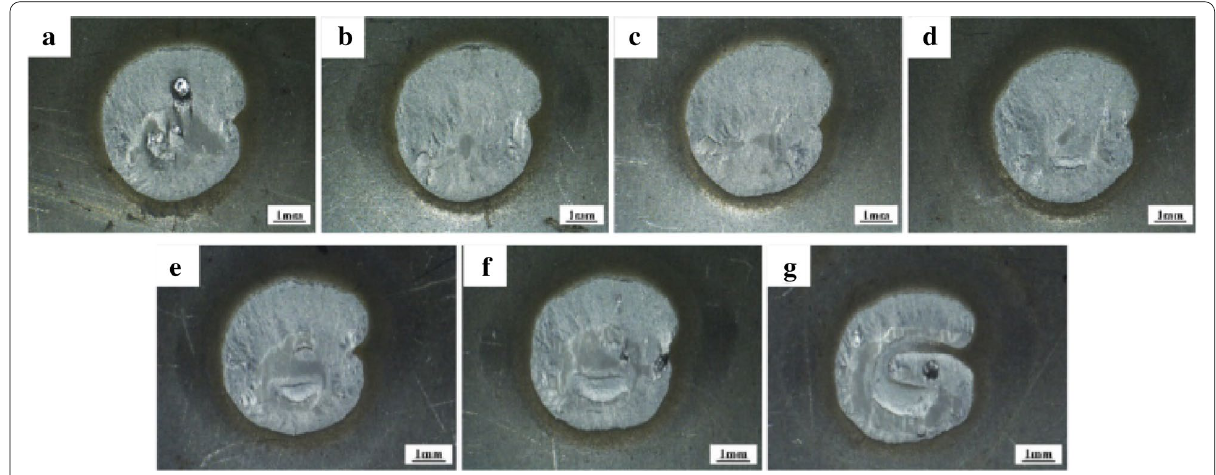
Figure 29 Tensile fracture morphology of welded joints under different duty cycles: a 35%; b 42%; c 46%; d 50%; e 54%; f 58%; g 75%